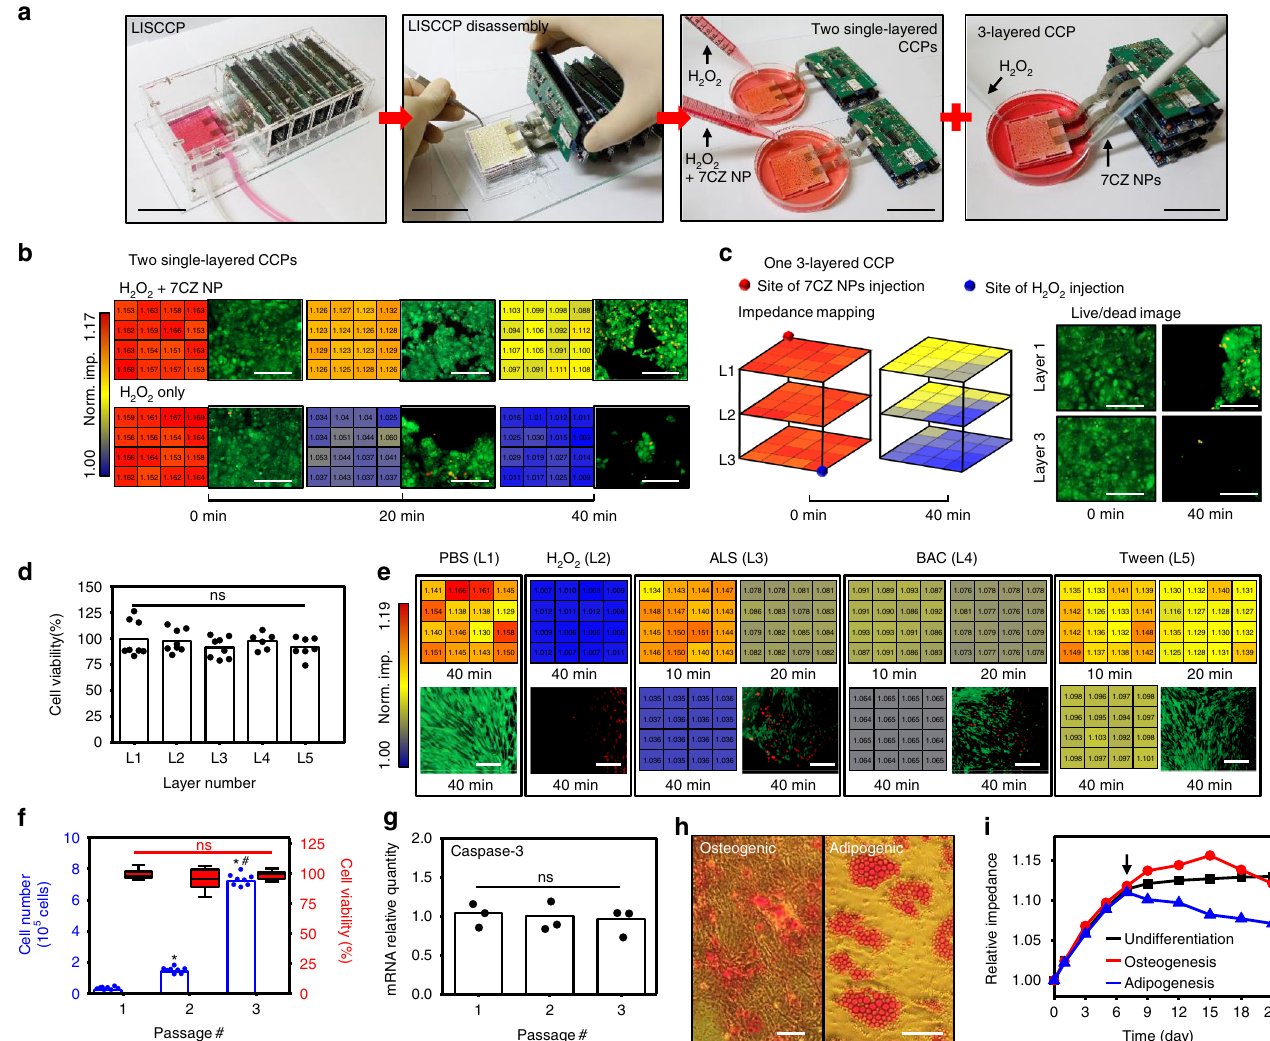
Fig. 6 Applications of multilayerd LISCCPs. a Photographs showing a multilayered LISCCP used for in vitro drug toxicity testing of drugs and cosmetics. LISCCP is divided into two single-layer CCPs and one triple-layered CCP to conduct three different tests. Scale bar: 5 cm. b Testing to evaluate the effects of 7CZ NP-mediated ROS scavenging on HL-1 using single-layer CCPs. The impedance mappings of HL-1 culture along with its corresponding live (green)/ dead (red) cell images are shown for the treatment of H 2 O 2 + 7CZ NPs (top) and H 2 O 2 only (bottom). Scale bar: 500 μ m. c Triple-layered impedance mapping of HL-1 treated with H 2 O 2 at one corner and 7CZ NPs at the opposite corner (left) and their live/dead cell images (right). Scale bar: 500 μ m. d Viability of hDFB cultured on each layer of LISCCP at t = 0 ( n = 8, mean ± s.d., ns, not signi fi cant, ANOVA). e Impedance mappings and live/dead cell images of hDFB treated with phosphate-buffered saline (PBS), H 2 O 2 , or one of the surfactants (ALS ammonium lauryl sulfate, BAC benzalkonium chloride, Tween TWEEN 60). Scale bar: 100 μ m. f Viability and number of hMSC cultured on LISCCP for three passages (cell number, n = 8, * P < 0.001 versus passage 1, # P < 0.01 versus passage 2, ANOVA with Bonferroni ’ s post-test; cell viability, n = 4, Box: median; 25th to 75th percentiles, Whisker: min to max, ns, not signi fi cant, ANOVA). Large expansion of cells shows the utilization of LISCCP in large-scale cell manufacturing for cell therapy. g Caspase-3 gene expression of hMSC cultured on LISCCP for three passages ( n = 3, ns, not signi fi cant, ANOVA with Bonferroni ’ s post-test). h Staining images of h MSC differentiated into osteogenic (left, Alizarin red O staining) and adipogenic (right, Oil red O staining) lineage cells. Red indicates osteogenic or adipogenic lineage cells. Scale bar: 50 μ m. i Impedance monitoring of hMSC cultures that were induced to undergo osteogenic and adipogenic differentiation by medium change on day 7 (arrow) when the cells were 90% con fl candidates (Fig. 6a – c), toxicity testing of cosmetic ingredients (Fig. 6d, e), and large-scale production of therapeutic cells factors secreted from earlier differentiated muscle cells at L3 to (Fig. 6f – i). For in vitro screening and testing, each layer of the surrounding layers. The pH pro fi le, however, shows no LISCCP can be separated for multiple testing of chemicals 35 . For example, two single-layered and one three-layered CCPs can be prepared from one LISCCP (Fig. 6a). (Fig. 5n), which may be due to the continuous medium circulation.